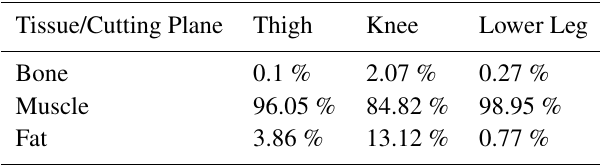
Tab.3: Current density contribution (in percentage) at 1